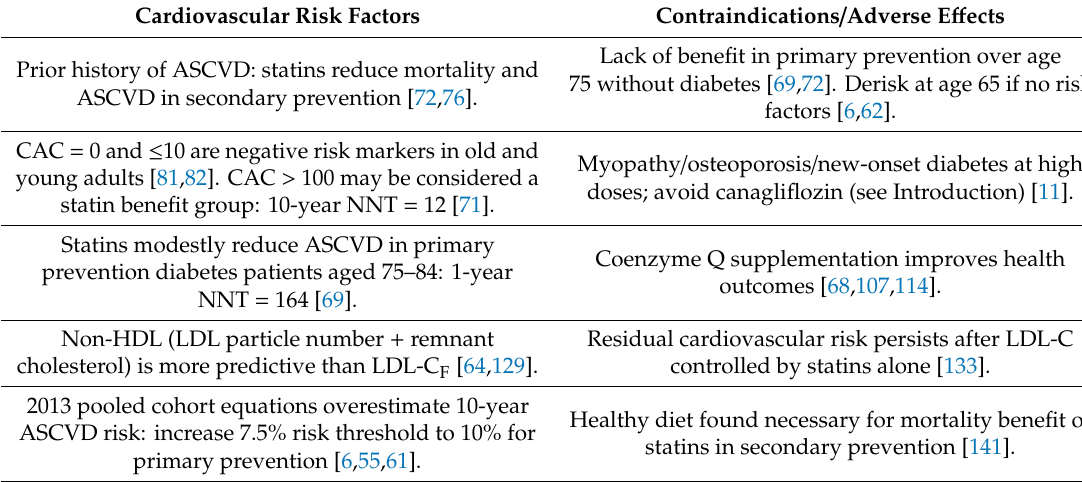
Table 2. Conclusions, statin benefit groups, and robust markers of cardiovascular risk. Cardiovascular Risk